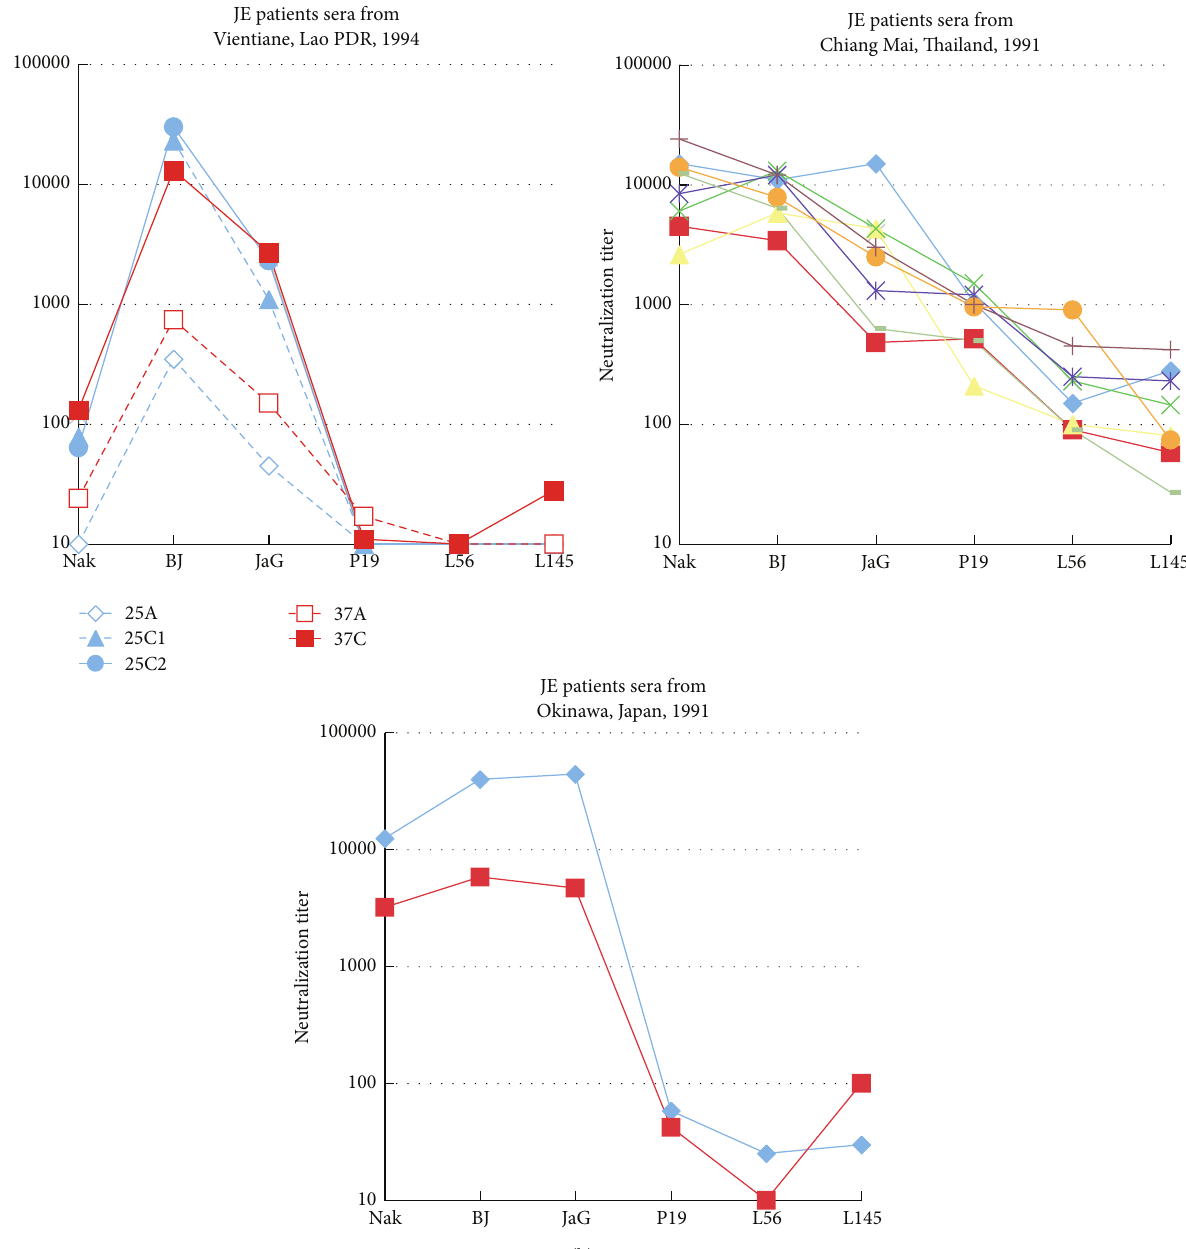
Figure 3: (a) Cross-neutralization testing on 6 JEV strains using polyclonal mouse antisera inoculated with different JEV strains: Nakayama, Beijing-1, P19-Br, LaVS56, and LaVS145. Vertical line: neutralizing antibody titers against JEV strains: Nakayama (Nak), Beijing-1 (BJ), JaGAr#01 (JaG), P19-Br (P19), LaVS56 (L56), and LaVS145 (L145) in a log 10 scale. (b) The reactivity of sera from JE patients of different regions: two cases of JE (A: acute sera, C: convalescent sera) from Vientiane, Lao PDR, in 1994; eight cases from Chiang Mai, Thailand, in 1991; and two cases from Okinawa, Japan, in 1991. Vertical line: neutralizing antibody titers against JEV strains as panel